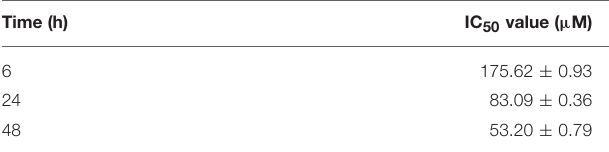
TABLE 1 | IC 50 value of pterostilbene inhibition of cell